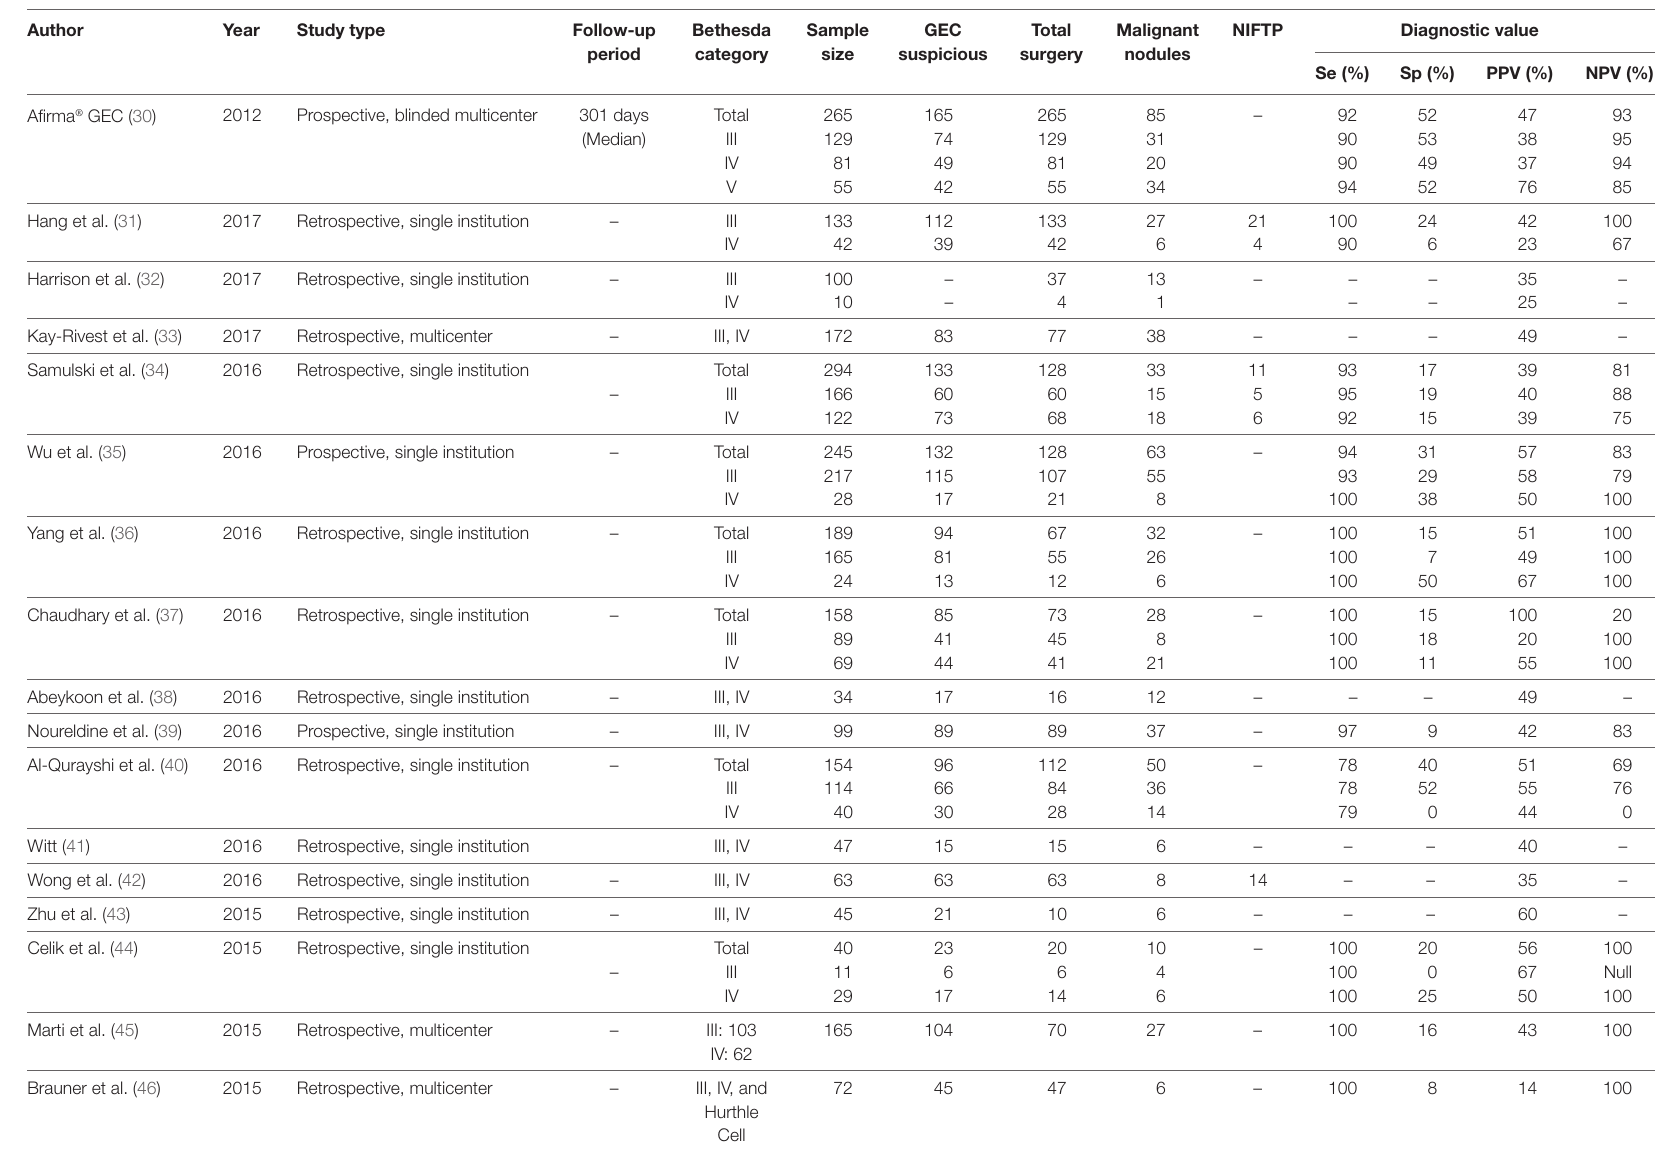
TAble 2 | Afirma Gene Expression Classifier (GEC) literature